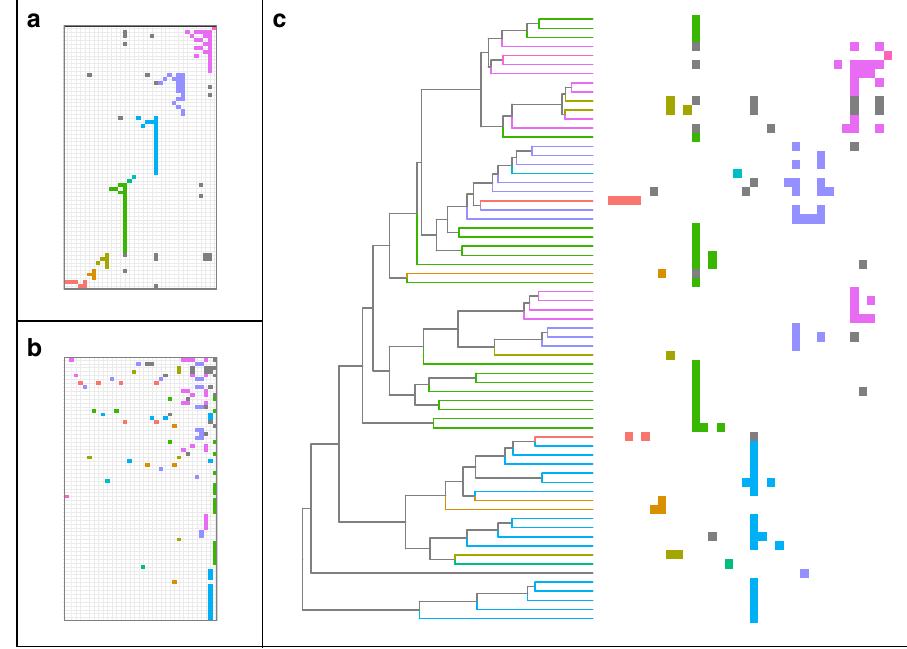
Fig. 4 Three different ways of viewing the Pieridae-plant network. Butter fl y genera are in rows and host plant families are in columns. Each fi lled cell indicates a butter fl y – plant interaction and each colour shows interactions within a module (grey cells are interactions between modules). a Rows and columns sorted to emphasise modular af fi nity (order of modules is arbitrary). b Rows and columns sorted to emphasise nestedness, ordered from the upper right corner according to descending number of interactions. c Resorting of the rows of the matrix (right) to match the Pieridae phylogeny (left) and highlight the phylogenetic diversity in each module. Branches of the phylogeny are coloured by module af fi liation of the terminal taxa. Note that module colours are consistent with Fig. 3. For taxon names see Supplementary Figs. 7 and 8